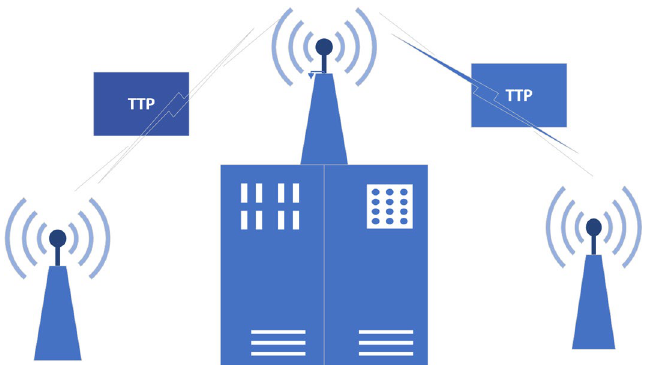
Fig. 3 Architecture of IoT gateway with TTP in internal